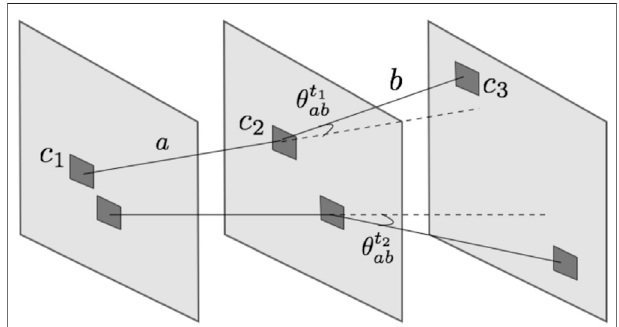
FIGURE 8 | Sketch of the cluster assignment to a track in the reconstruction algorithm (not to scale). The MAPS planes are represented in light gray, while the clusters are highlighted in dark gray. c 1 , c 2 , and c 3 belong to track t 1 . a and b are the segments between c 1 -c 2 and c 2 -c 3 , respectively. The angle θ t 1 ab is reported, as well as for the second track t 2